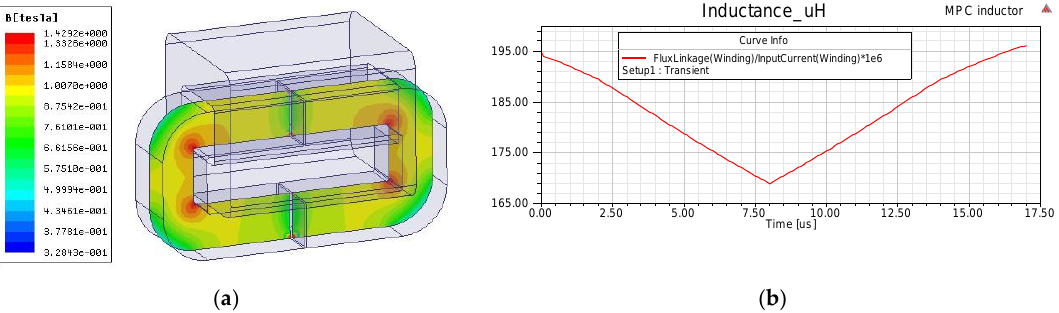
Figure 7. ANSYS Maxwell simulation results for ( a ) flux distribution inside inductor core; ( b )